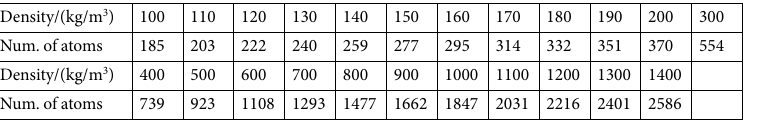
Table 1. Initial states of argon in simulation box at 100 K. The initial pressure of a box with argon density of 100 kg/m 3 at 100 K is ~30.5 bar. (In the present study, we set 1 bar = 1.013 × 10 5 Pa). Atom i